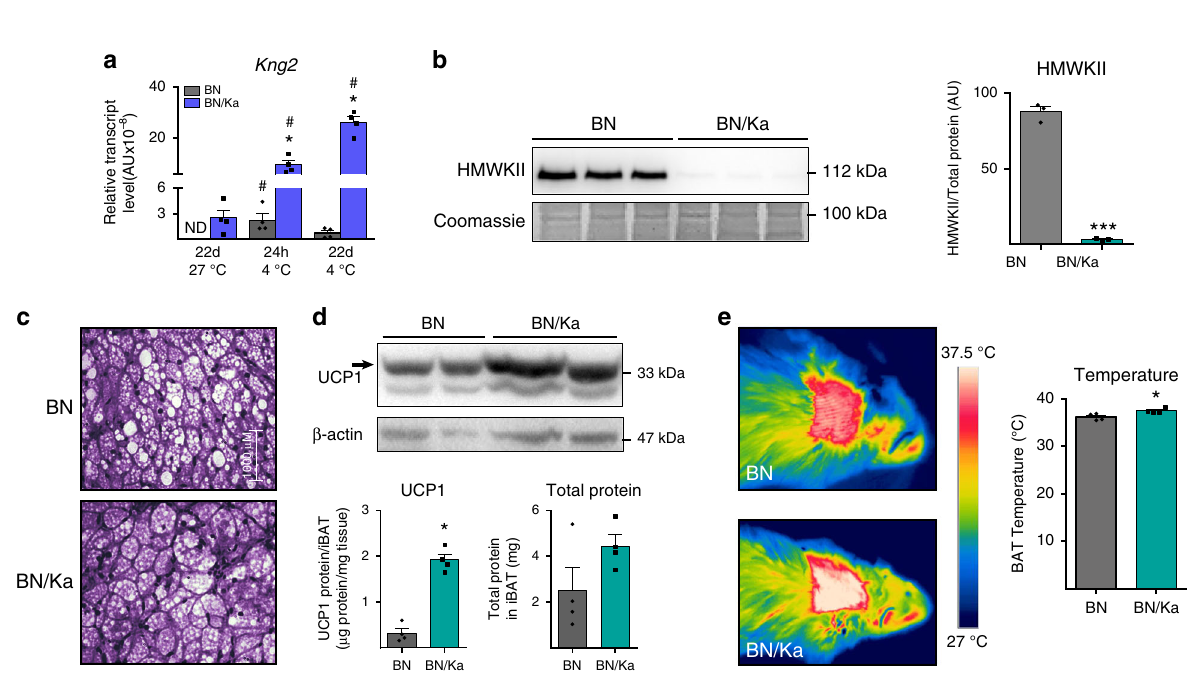
Fig. 3 Regulation of Kng 2 expression and BAT activity in BN/Ka rats. a mRNA expression of K-kininogen ( Kng2 ) in iBAT from 12 weeks old BN and BN/ Ka rats at thermoneutrality (27 °C) and after 24 h or 22 days exposure to cold (4 °C) ( n = 4 animals). b HMW-KNG2 protein expression in plasma and quanti fi cation in BN and BN/Ka rats under thermoneutral conditions ( n = 3 animals). c Optical microscopy of H&E-stained iBAT from BN and BN/Ka rats under thermoneutral conditions ( n = 4 animals). d UCP1 protein expression and quanti fi cation of UCP1 protein levels, expressed per tissue and total protein (below), in iBAT from BN and BN/Ka rats under thermoneutral conditions ( n = 4 animals). e Representative infrared thermographies (left) and quanti fi cation of iBAT temperature (right) in BN and BN/Ka rats under thermoneutral conditions ( n = 4 animals). ND, not detectable. Data are presented as means ± s.e.m. (bars). * P < 0.05 and *** P < 0.001 versus BN; # P < 0.05 versus thermoneutrality. P -values determined by two-tailed unpaired Student ’ s t - test (for genotypes) and two ways ANOVA with Tukey ’ s post hoc test (for temperature) ( a ) and two-tailed unpaired Student ’ s t -test ( b , d , e ). Source data are provided as a Source data fi norepinephrine, CL316243 and cAMP treatments, all of which elicited enhanced thermogenic activation, as shown by the induction of Ucp1 transcript levels (Fig. 2b). In primary adipocyte cultures from iWAT precursors, induction of beiging by rosigli- tazone (see massive induction of Ucp1 gene transcript levels) also resulted in a tendency of HMWK Kng2 transcripts to increase and caused a signi fi cant induction of LMWK Kng2 transcript levels (Fig. 2c, top). Moreover, in differentiated beige adipocytes, CL316243 and cAMP increased KNG2 protein levels (Fig. 2c, bottom).